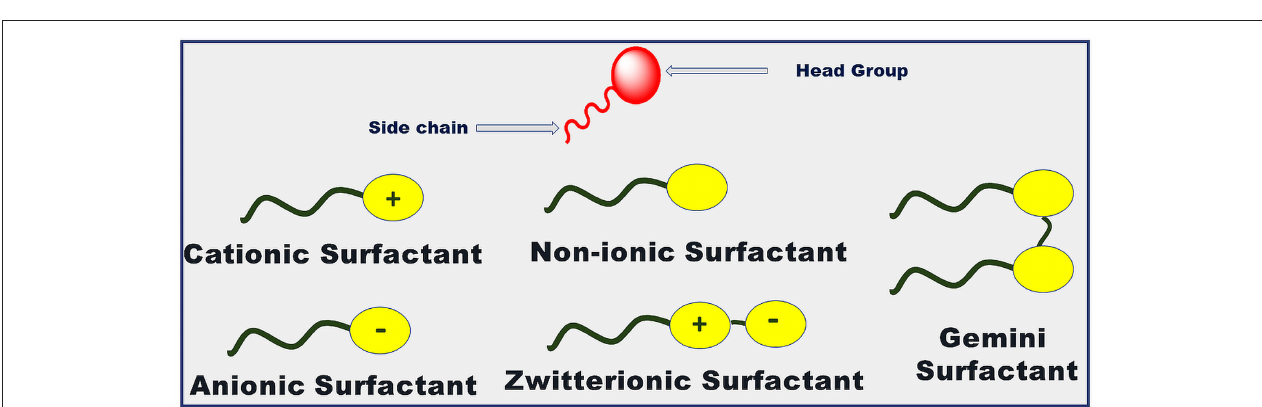
FIGURE 2 | Molecular structures of various types of surface-active ionic liquids (SAILs).